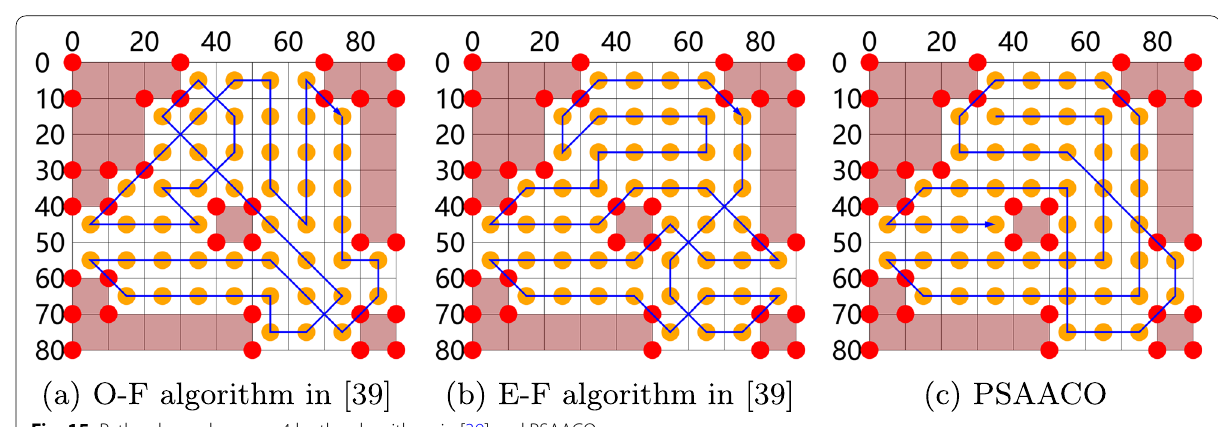
Fig. 15 Paths planned on area 4 by the algorithms in [39] and PSAACO